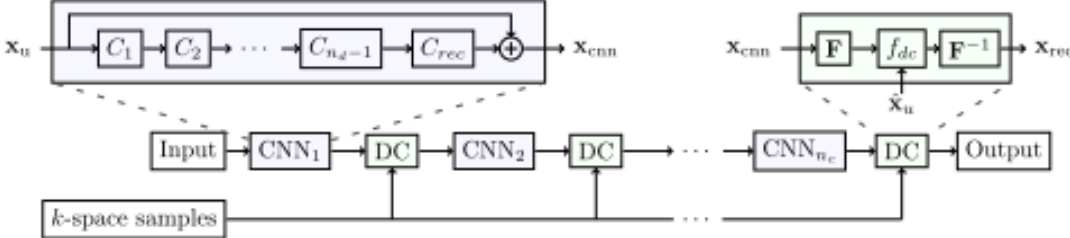
Figure 3. Illustration of the Cascade-net from [11]. Here, each C i is a convolutional block of 64 filters (48 in our implementation) followed by a ReLU non-linearity, n d is the number of such convolutional blocks forming a convolutional subnetwork between each data consistency layer DC , and n c is the number of convolutional